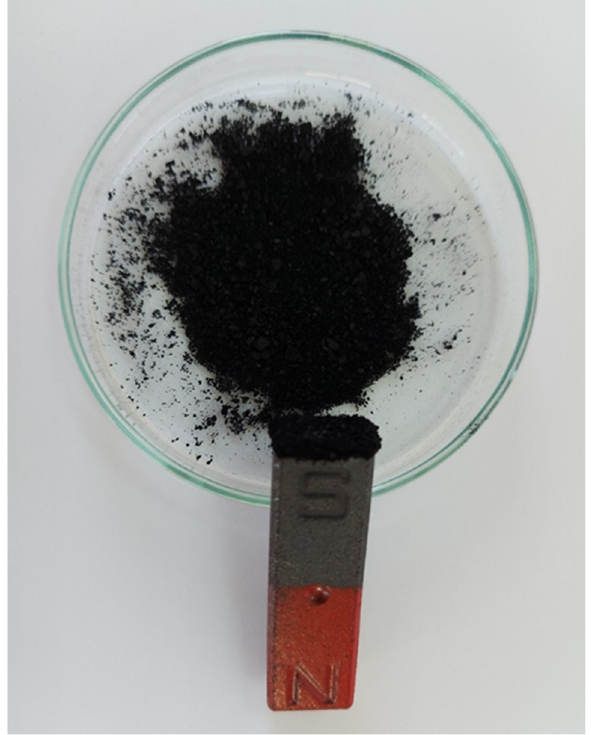
Figure 10. Black, solid adsorbent material generated by grinding the CrFeO 3 composite.